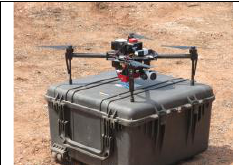
Figure 2. Picture of the DJI Matrice 100 quadcopter mounted with a Micasense RedEdge narrowband camera